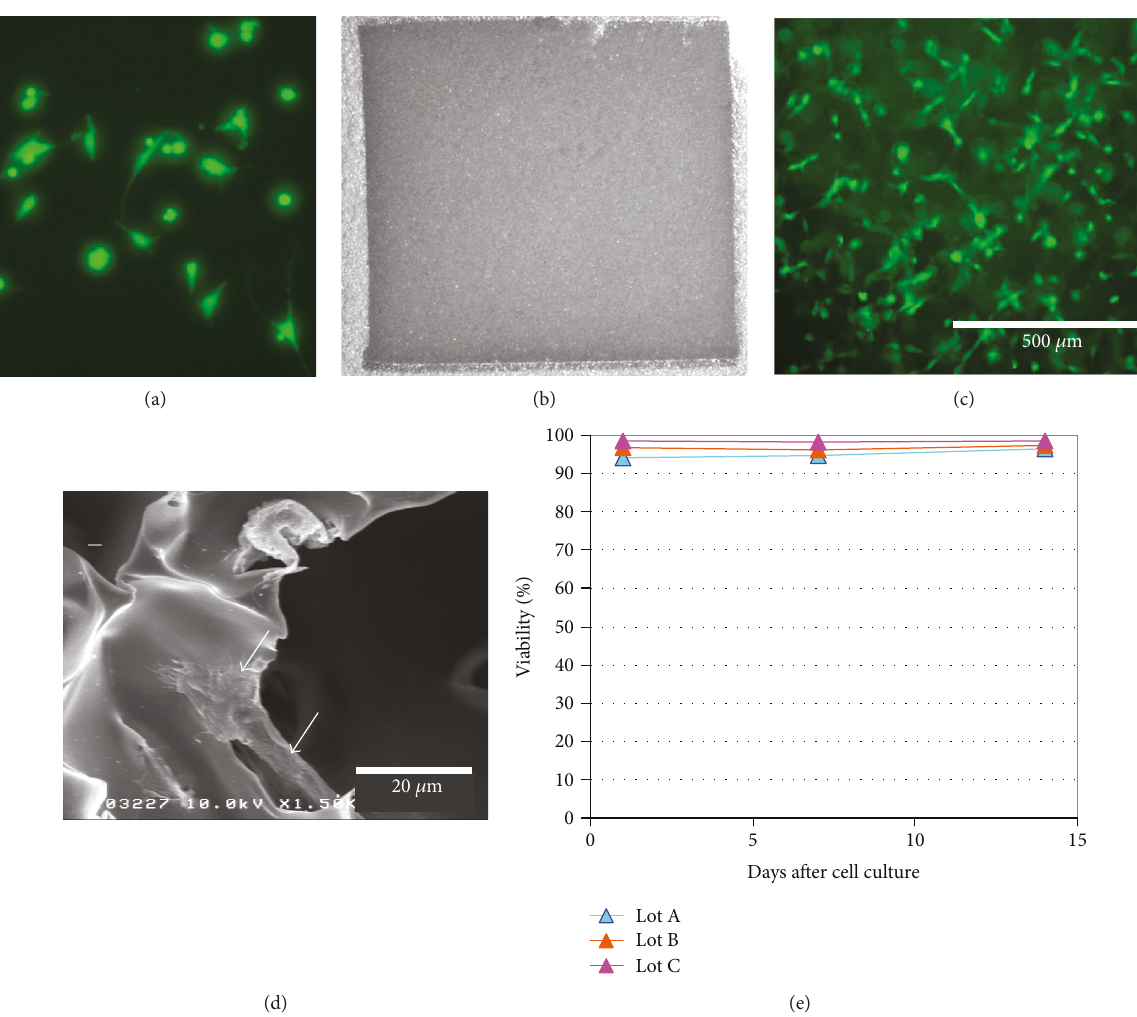
Figure 1: Analysis of RCP sponges with cultured BMSCs. Panel (a) shows a fl uorescence photomicrograph of cultured rat GFP-BMSCs. Panels (b) and (c) show photomicrographs of the RCP sponge before cell culture (b) and 14 days after the second cell passage (c). Panel (d) shows a photomicrograph of BMSCs on the RCP sponge, using scanning electron microscopy. Panel (e) shows the line graph of the cell viability in RCP sponge. The arrow in (d) indicates a surviving BMSC on the RCP sponge. Scale bars: 500 μ m (c) and 20 μ m